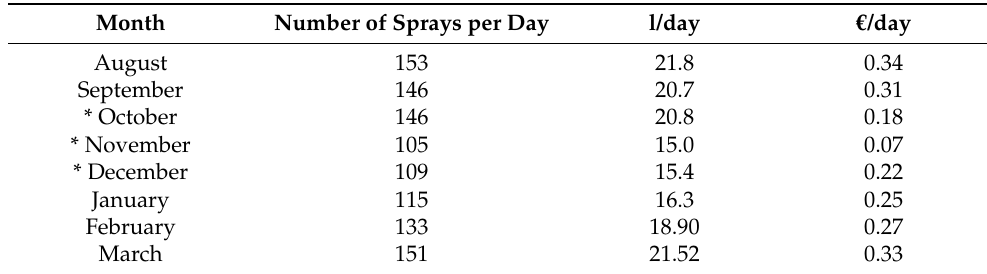
Table 6. Average daily water consumption for the spray operation of PV3 and PV4 systems in the considered monitoring